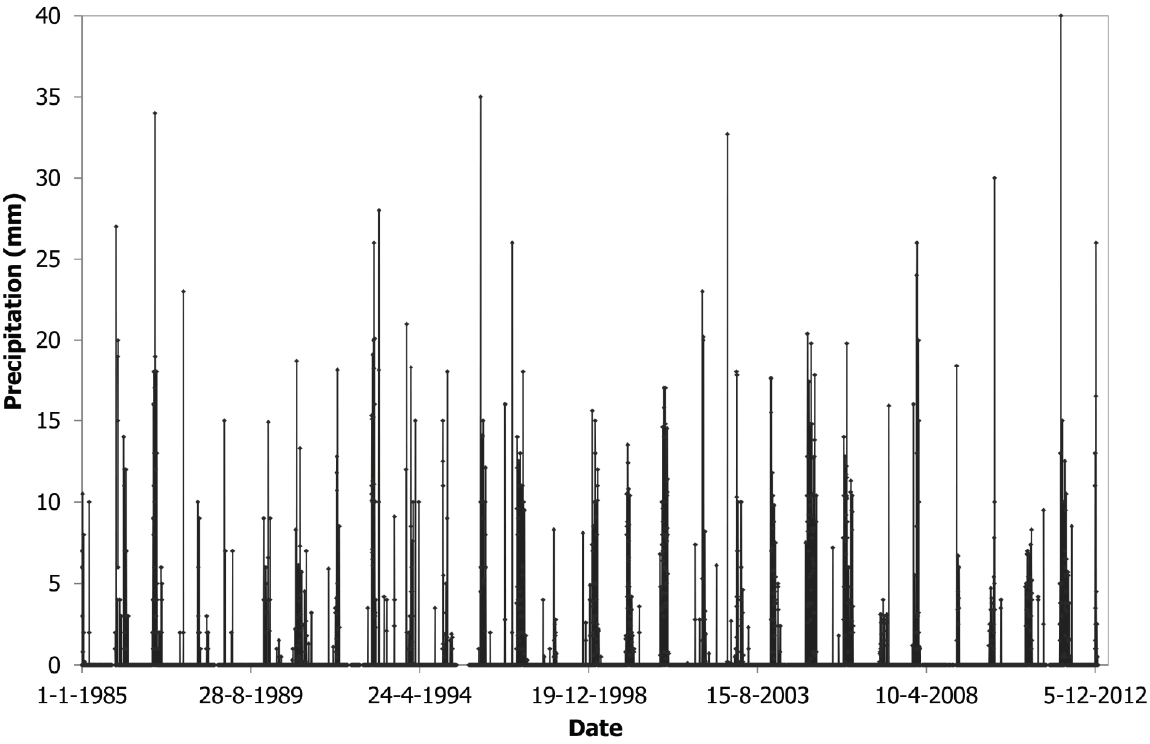
Figure 2. Daily precipitation in the study area